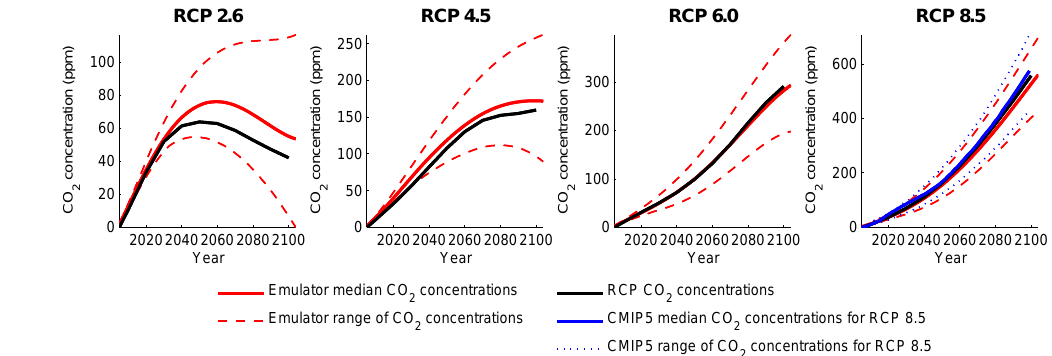
Figure 2. Carbon cycle emulator output compared with RCP data, for the four RCPs 2.6, 4.5, 6.0 and 8.5. Anomalies are relative to 2005. For RCP8.5, CMIP5 data are presented as a